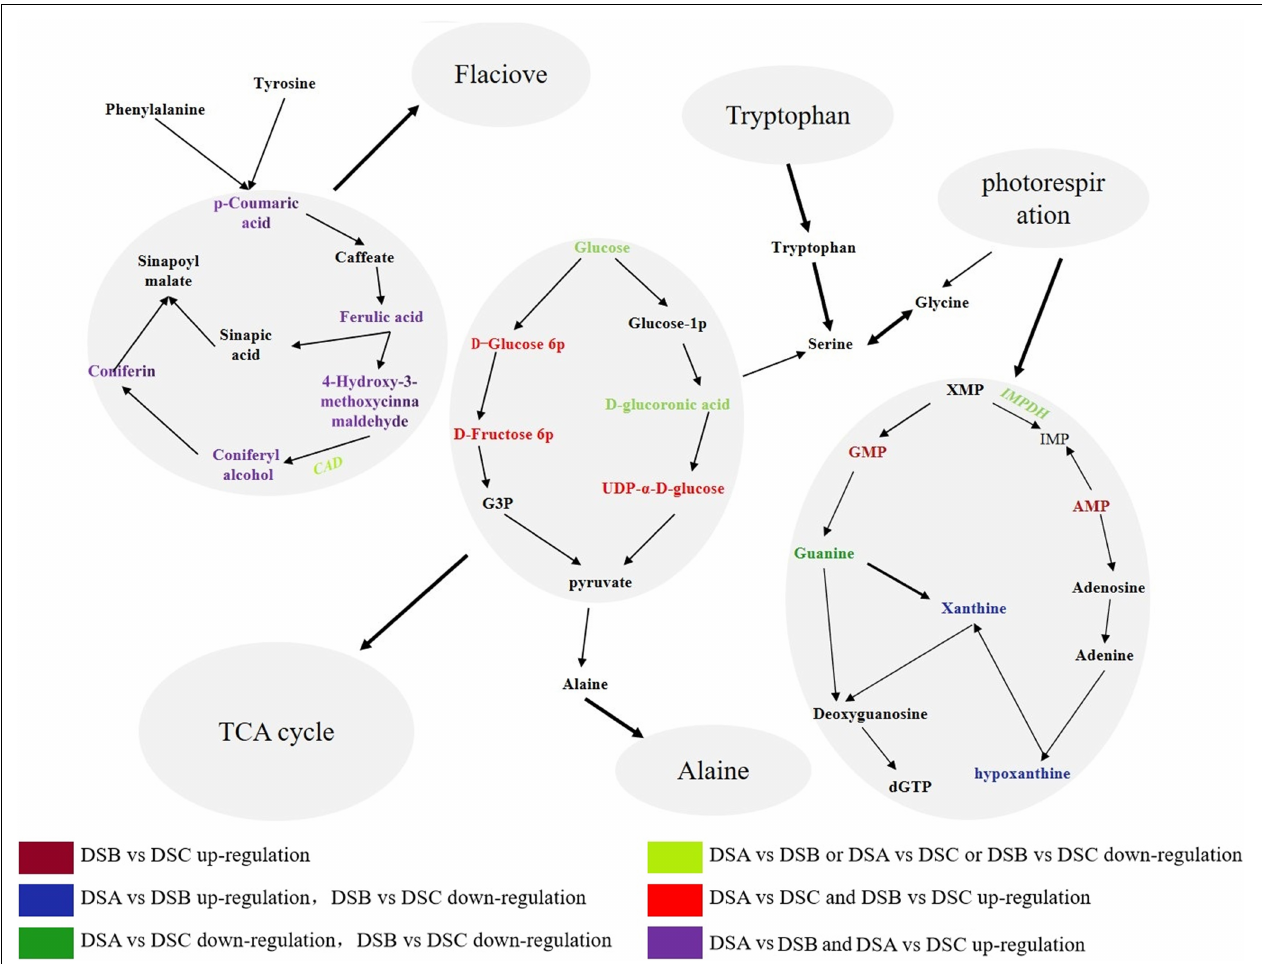
FIGURE 7 | Pathway diagram of major metabolic pathways. This pathway is constructed based on the KEGG pathway. The color denotes the different expression levels. Dark red denotes upregulation in DSB vs. DSC, blue shows that DEGs or metabolites are upregulated in DSA vs. DSB and downregulation in DSB vs. DSC, strong green denotes downregulation in DSA vs. DSB and DSB vs. DSC. Blue denotes downregulation in DSA vs. DSB or DSA vs. DSC or DSB vs. DSC, red denotes upregulation in DSA vs. DSB and DSB vs. DSC, and purple denotes with upregulation in DSA vs. DSC and DSB vs. DSC.